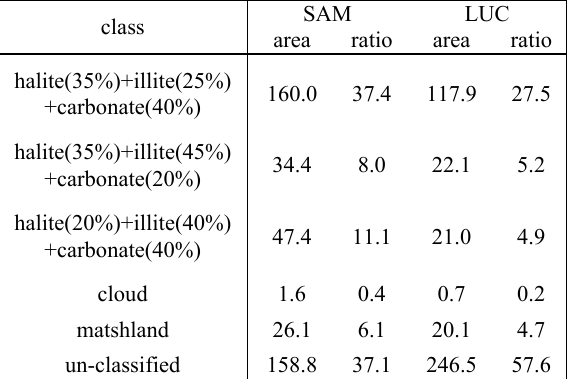
Table 1. Comparison of SAM and LSU results of Hyperion image